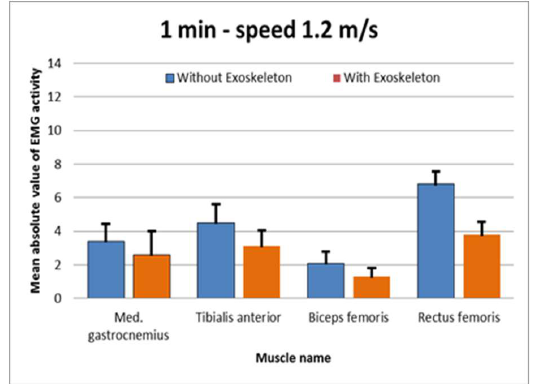
Fig. 12. Mean EMG activities of the right leg muscles of the healthy subject during walking on treadmill at fixed speed 0.8 m/s for 3 minutes without and with the exoskeleton.